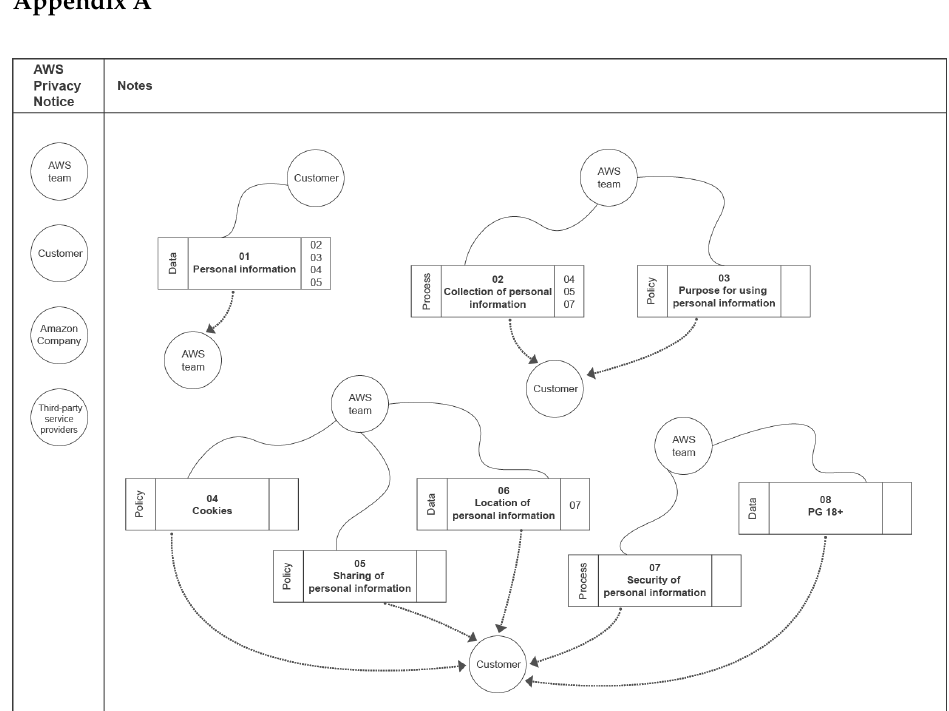
Figure A1. Shield diagram for AWS terms and conditions. Table A1. AWS: SitReq specification for customers